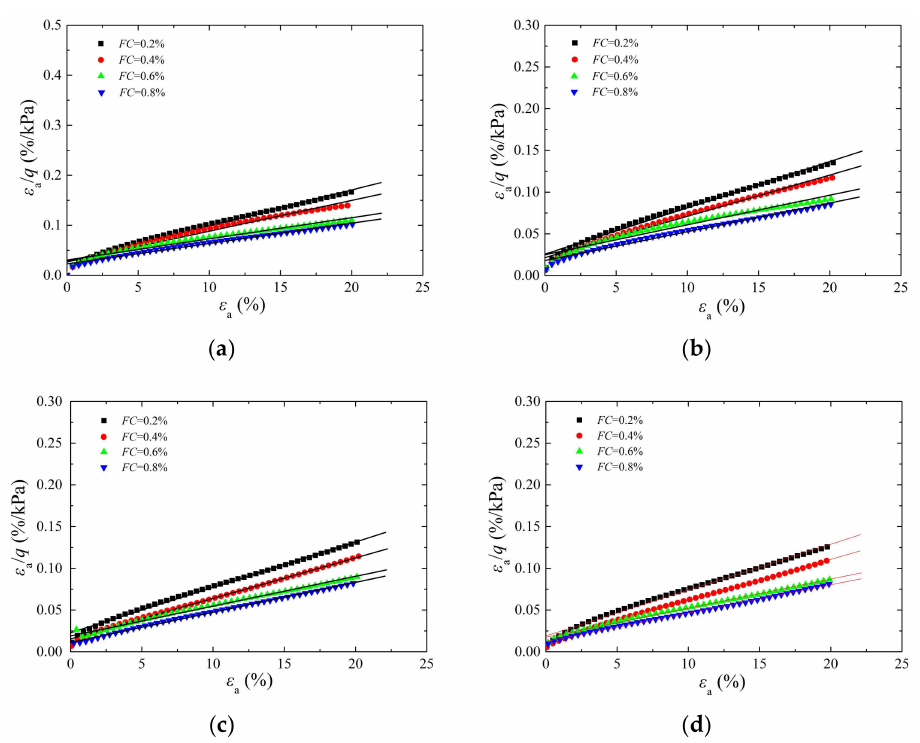
Figure 7. Fitting of the test results under 50 kPa cell pressure: ( a ) FL = 4 mm; ( b ) FL = 8 mm; ( c ) FL = 12 mm; ( d ) FL = 16 mm. Table 4. Model parameters under 50 kPa cell